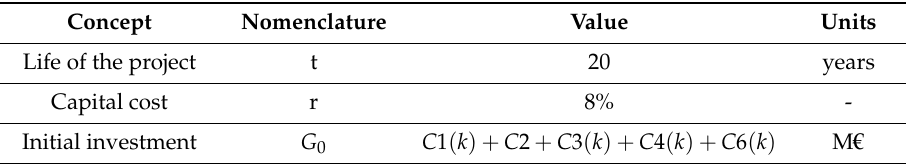
Table 7. Economic parameters.